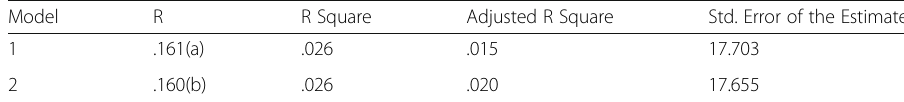
Table 6 R-value of Independent Variables Model